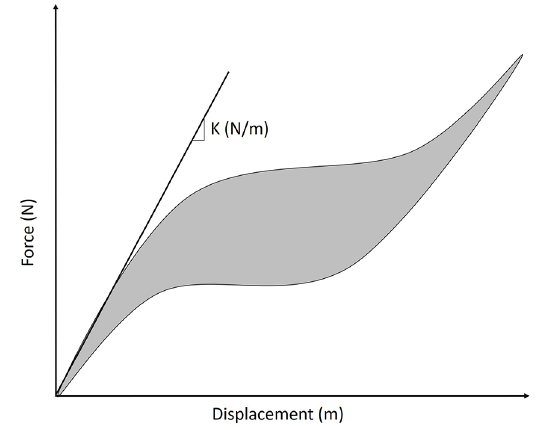
Figure 2 . Schematic representation of the determination of stiffness (k) from a typical superelastic Force vs Displacement